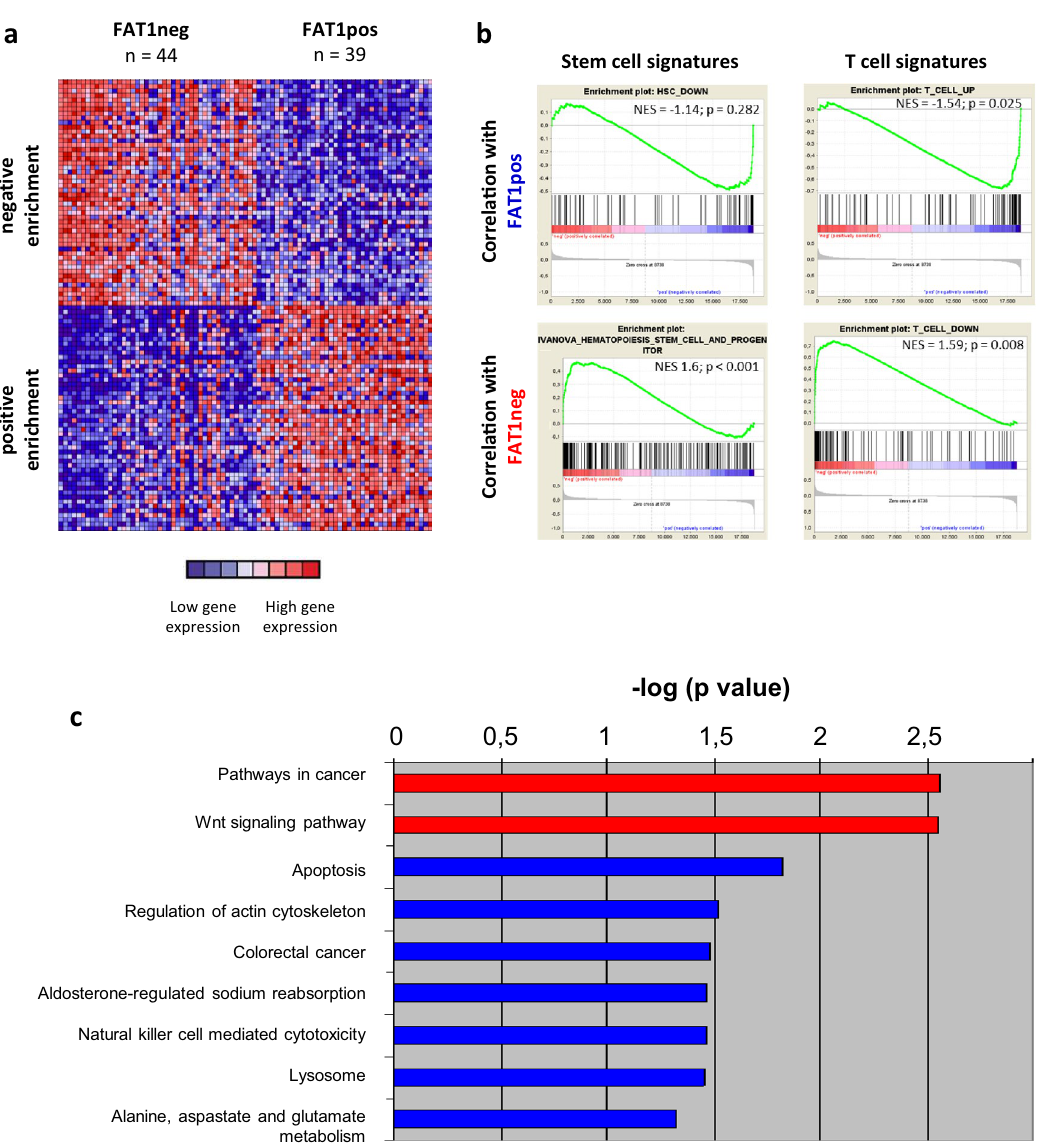
Figure 3. FAT1 -dependent gene expression in T-ALL ( a ) Heatmap of coexpressed top 50 most up- and downregulated genes according to expression in FAT1 positive or negative samples is depicted for a dataset of n = 83 T-ALL patients. FAT1pos samples display a FAT1 -dependent expression pattern. ( b ) GSEA comparing FAT1pos with FAT1neg patients showed a strong correlation between FAT1 expression and T-ALL maturity with respect for mature T-cell and stem cell signatures. ( c ) Modules Pathways in cancer and WNT signaling are significantly upregulated and most prominent in FAT1pos thymic T-ALL patient